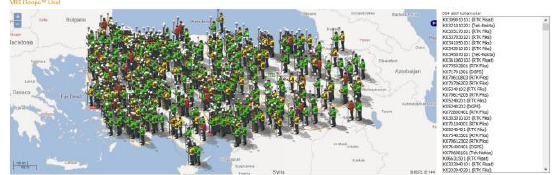
Figure 5. Real Time Monitoring of Users FKP Field Correction